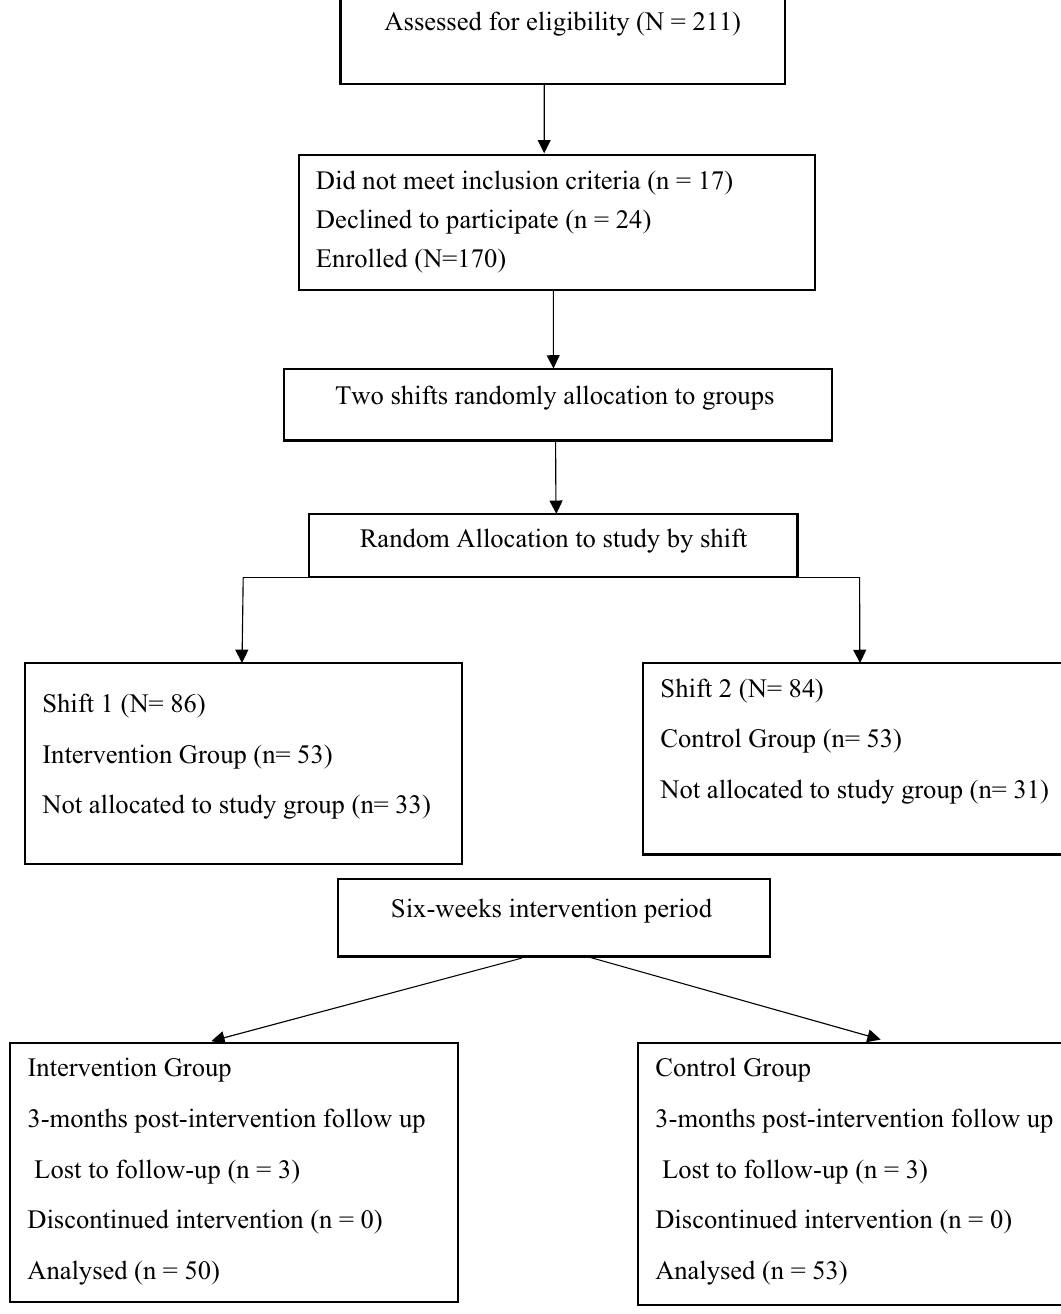
Figure 1. Consort flow diagram of the study. 211 employees who participants worked one of two 12-hour shifts in an industrial plant were invited into the study. 170 gave informed consented. One shift was randomly allocated as the educational intervention group the other was the control group. From potential participants 53 participants were randomly allocated into each study group. Three participants dropped out of the Intervention Group before the three-months post-intervention follow-up which was on the same day for both groups. Thus, data was analysed from 50 participants in the Intervention group and compared with 53 participants in the control